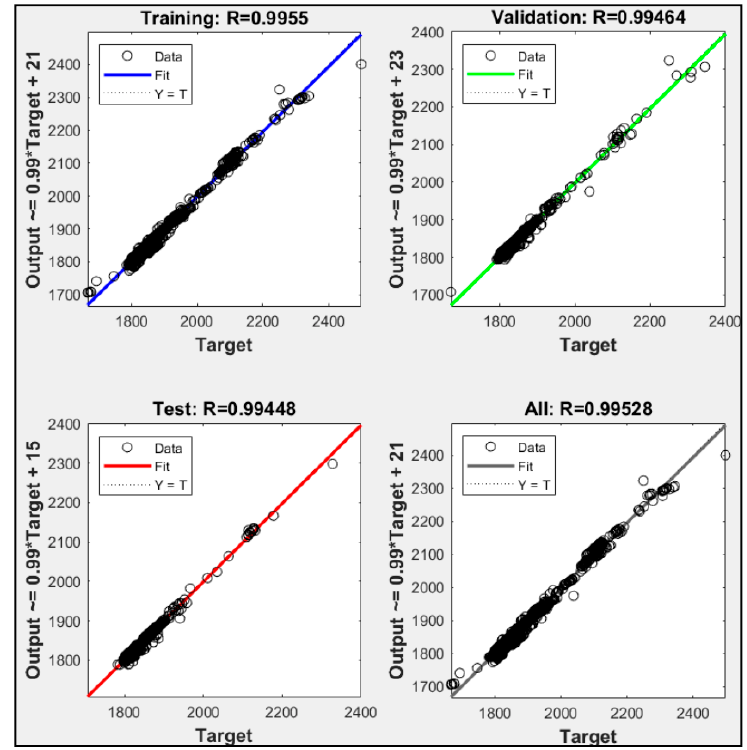
Figure 14. Regression of P1 + P2 + P3.